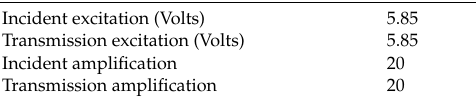
Table 4. Parameters used in Amplifier.